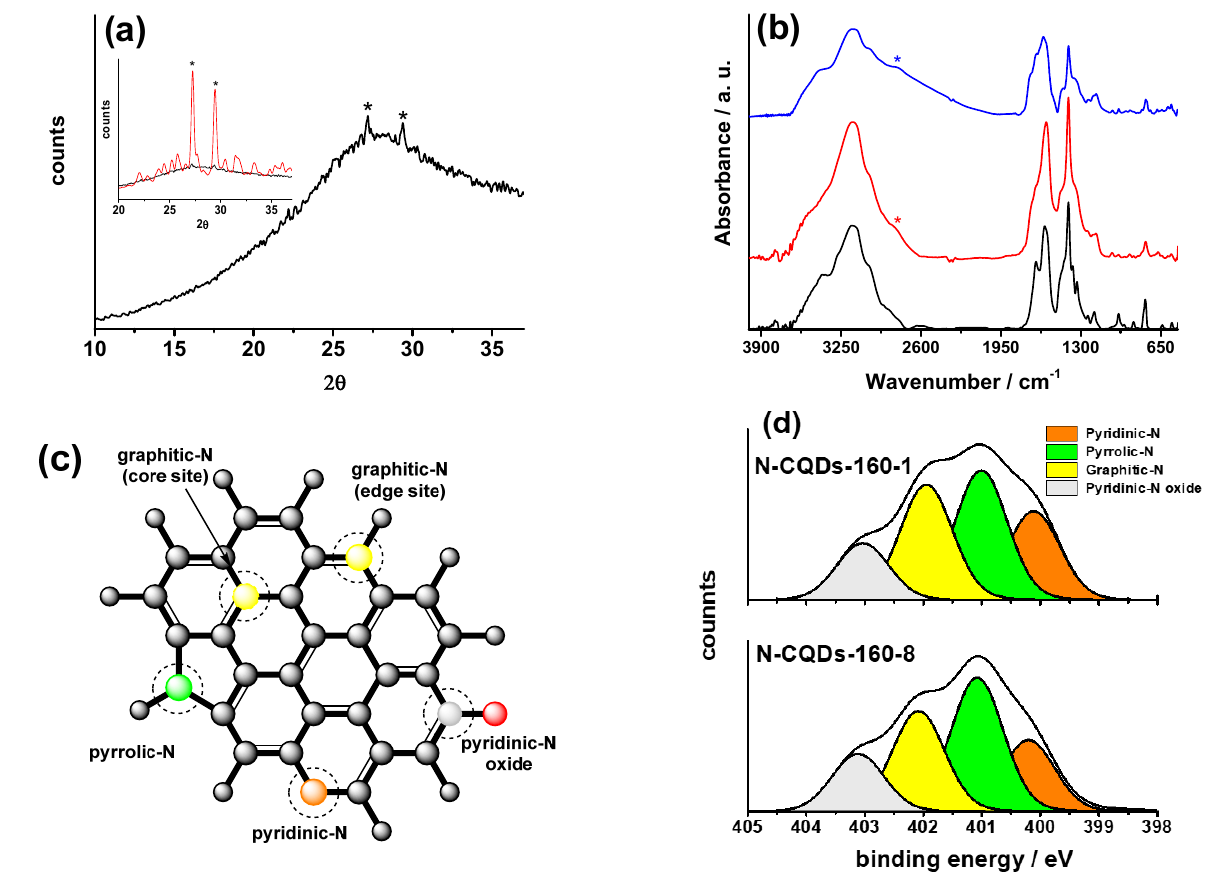
Figure 1. ( a ) XRD pattern of N-CDs-160-8. Inset XRD of sample N-CDs-160-1 (red line) and N-CQDs- 160-8 (black line); ( b ) FT-IR spectra of samples N-CDs-160-1 (black-line), N-CDs-160-8 (red line) and N-CDs-160-8 thermally treated at 80 °C for 1 week (blue line); ( c ) structure of common types of N-doping/functionalizations in N-CDs; ( d ) XPS high-resolution spectra of N 1s of N-CD samples. FT-IR spectroscopy : FT-IR spectroscopy was employed to study the nature of the